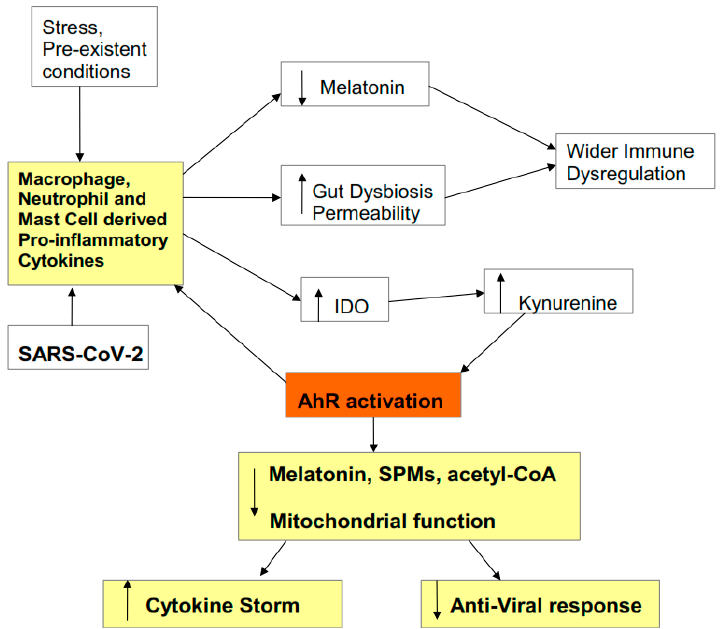
Figure 1. Pro-inflammatory cytokines decrease melatonin and increase gut permeability/dysbiosis, which contributes to immune dysregulation. Pro-inflammatory cytokines also increase indoleamine 2,3-dioxygenase (IDO), leading to kynurenine activation of the aryl hydrocarbon receptor (AhR). This potentiates the initial ‘cytokine storm’ and inhibits the endogenous anti-viral response, via the suppression of mitochondrial function, melatonin, acetyl-coenzyme A (CoA), and specialized pro-resolving mediators (SPMs). Stress, including racial discrimination stress, and pre-existent medical conditions prime and potentiate an elevated pro-inflammatory cytokine response, including via elevated kynurenine activation of the AhR.